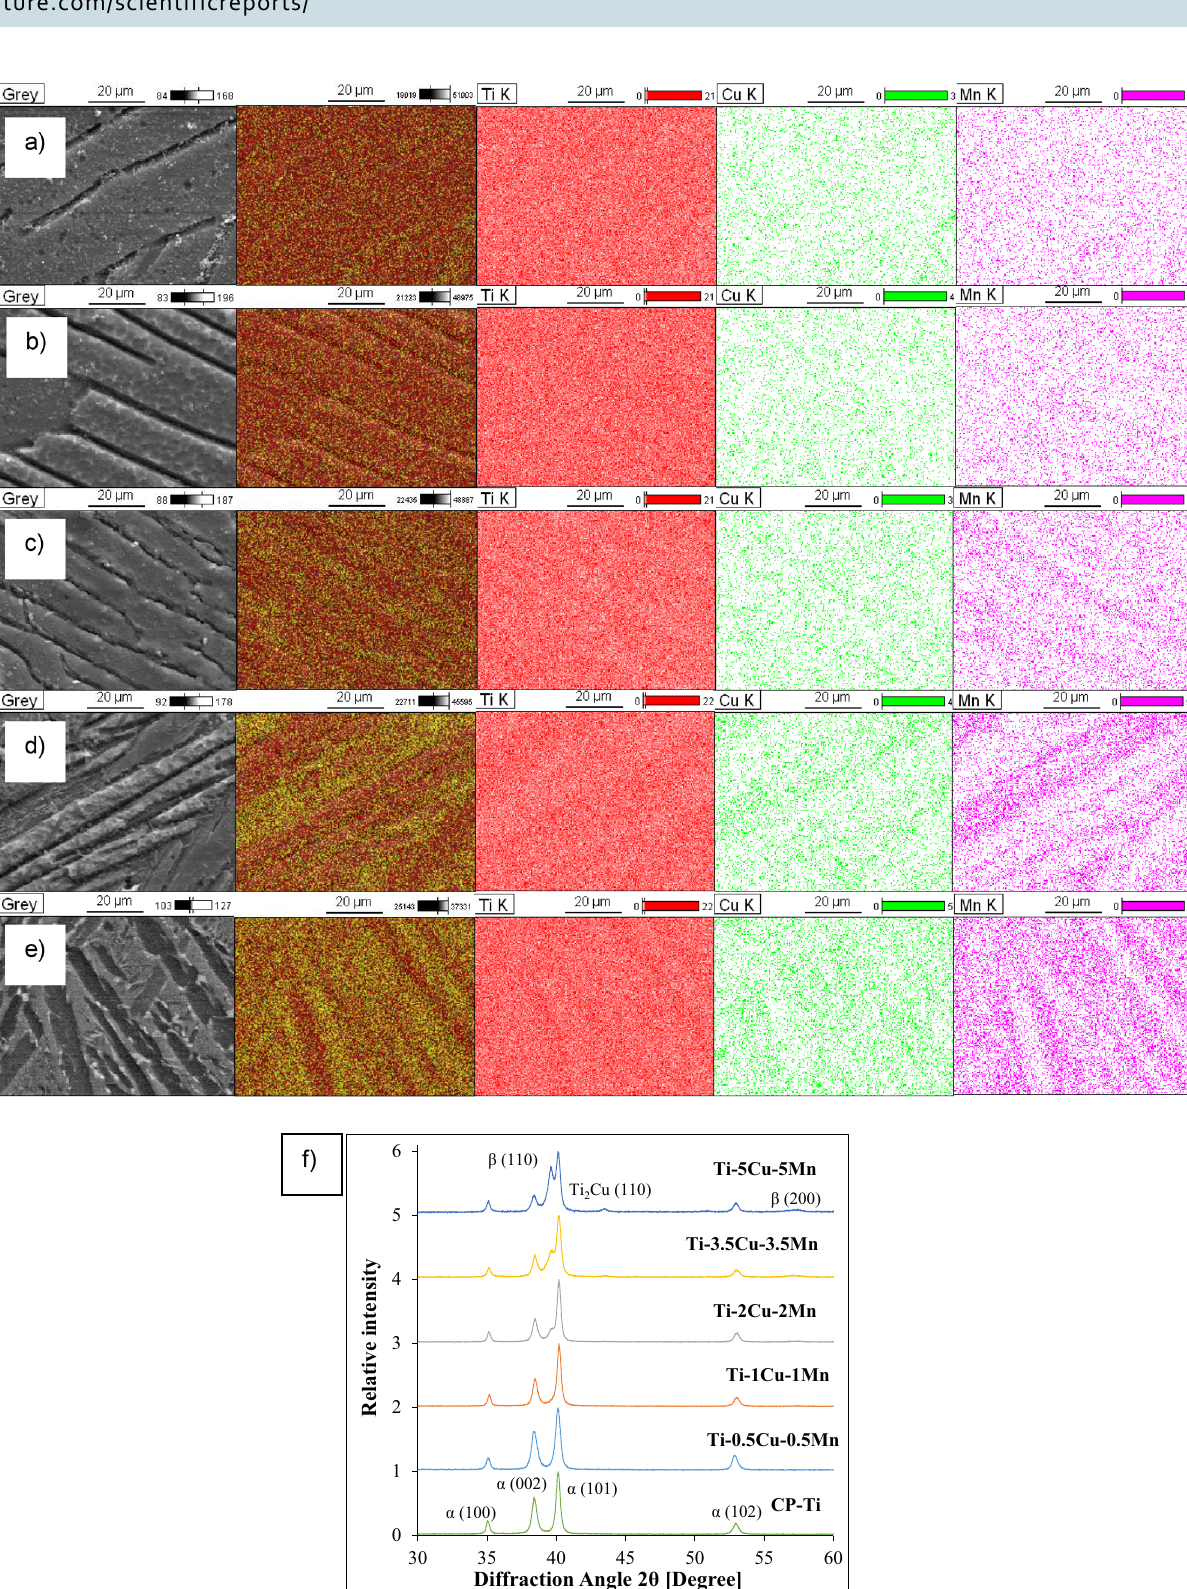
Figure 2. Representative results of the identification of the phases (via elemental mapping) for: ( a ) Ti–0.5Cu– 0.5Mn, ( b ) Ti–1Cu–1Mn, ( c ) Ti–2Cu–2Mn, ( d ) Ti–3.5Cu–3.5Mn, and ( e ) Ti–5Cu–5Mn, and ( f ) XRD patterns of the β eutectoid bearing functionalised Ti